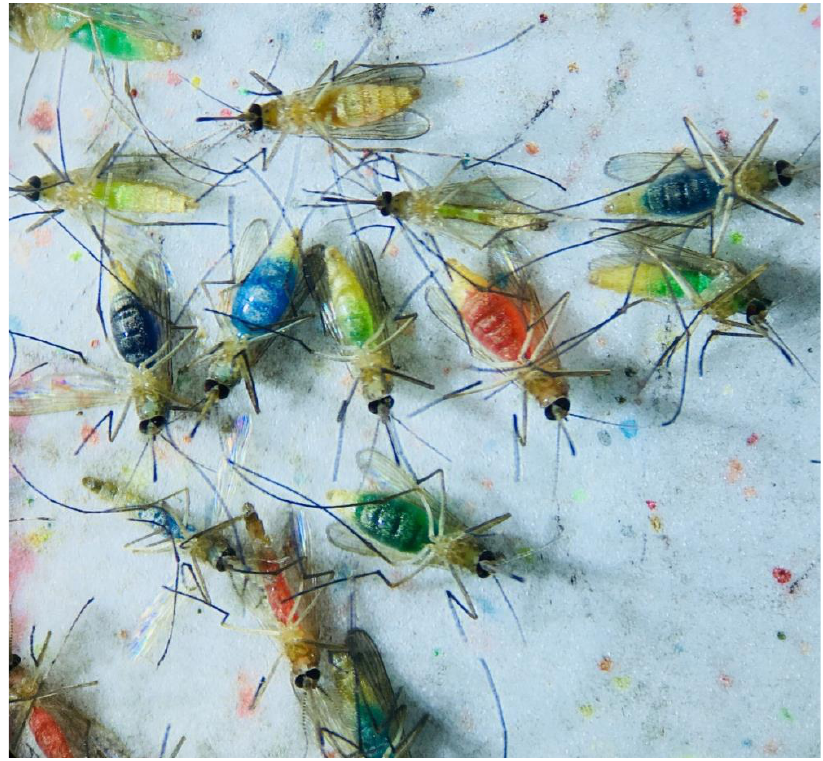
Figure 3. Excerpt from visual analyses of the mosquitoes of the four-choice feeding assay. The colors red, blue, green and yellow were offered simultaneously as ink – fructose – water solutions. Shown here is the wide range of color nuances of the original four offered colors. These results are due to ingesting different foraging amounts of the colored solution as well as the foraging from different colors.